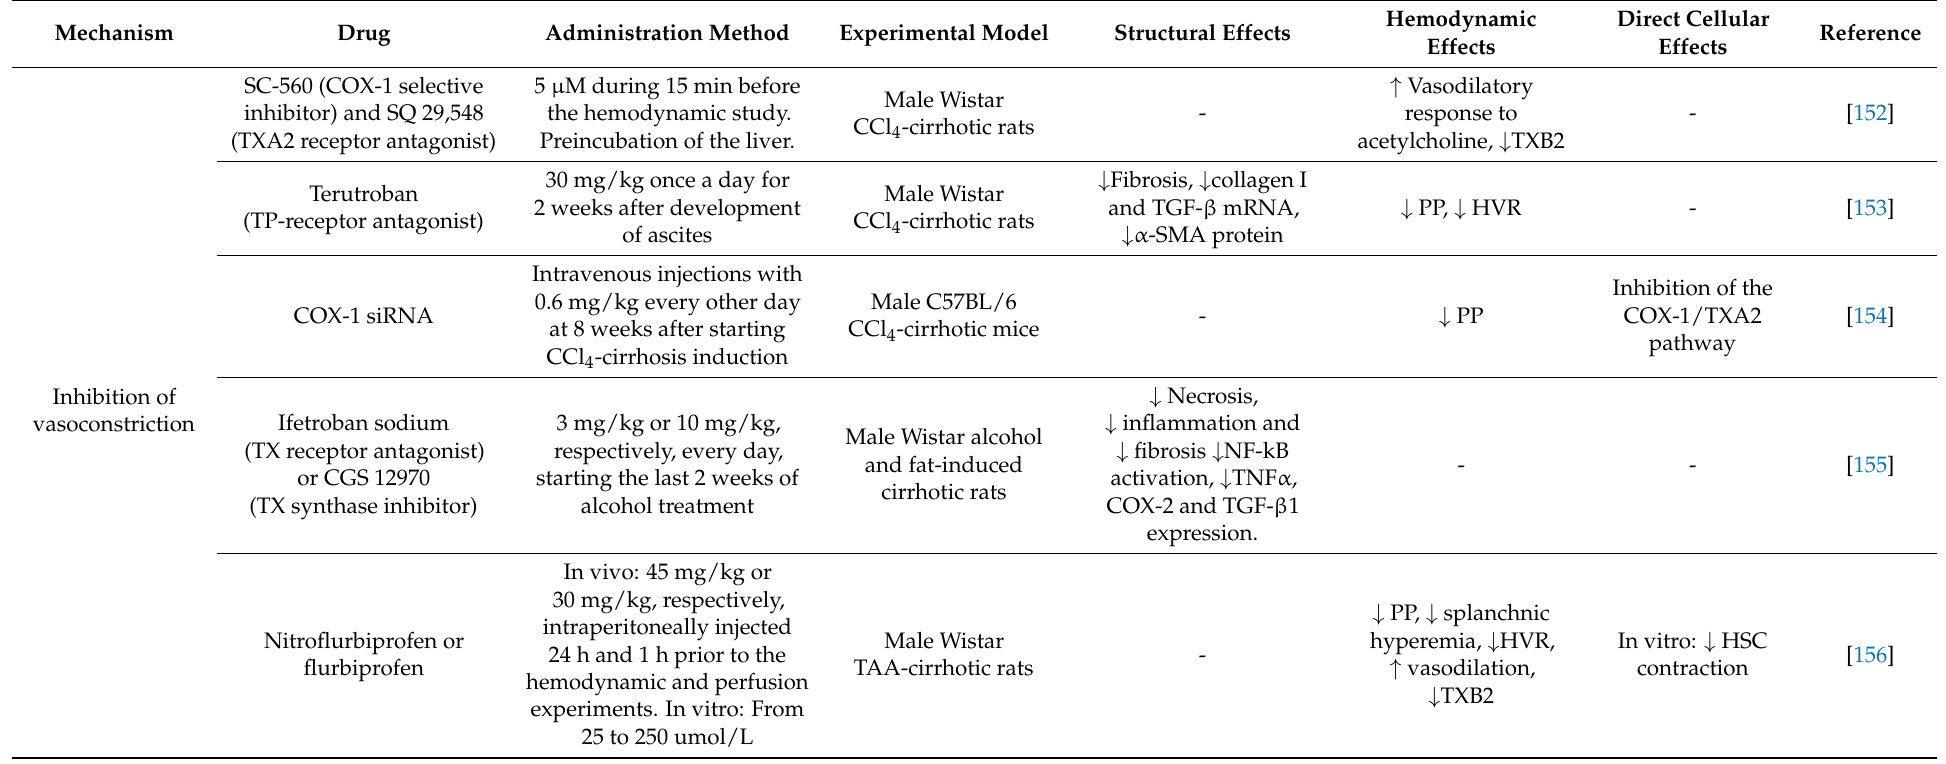
Table 1. Therapeutic strategies with described effects improving the sinusoidal cell phenotype. We classified the reported effects of each study according to whether they directly targeted the main cells of the sinusoid (direct cellular effects), the hemodynamics of the liver (the dynamic component of hepatic vascular resistance), or structural effects (static component of hepatic vascular resistance, e.g., fibrosis or necrosis). ACLF, acute on chronic liver failure; ACLD, advanced chronic liver disease; ASK1, apoptosis signal-regulating kinase 1; BDL, common bile duct ligation; CH, cirrhosis; CTP, Child-Turcotte-Pugh; eNOS, endothelial nitric oxide synthase; ET, endothelin receptor; HFD, high-fat diet; HFGFD, high-fat glucose-fructose